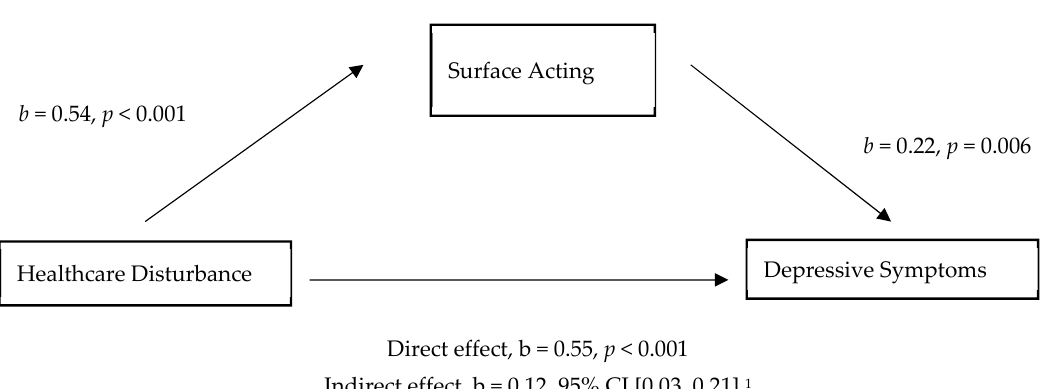
Figure 1. Model of healthcare disturbance as a predictor of depressive symptoms, mediated by surface acting. 1 The confidence interval for the indirect effect is a BCa bootstrapped CI based on 1000 samples.